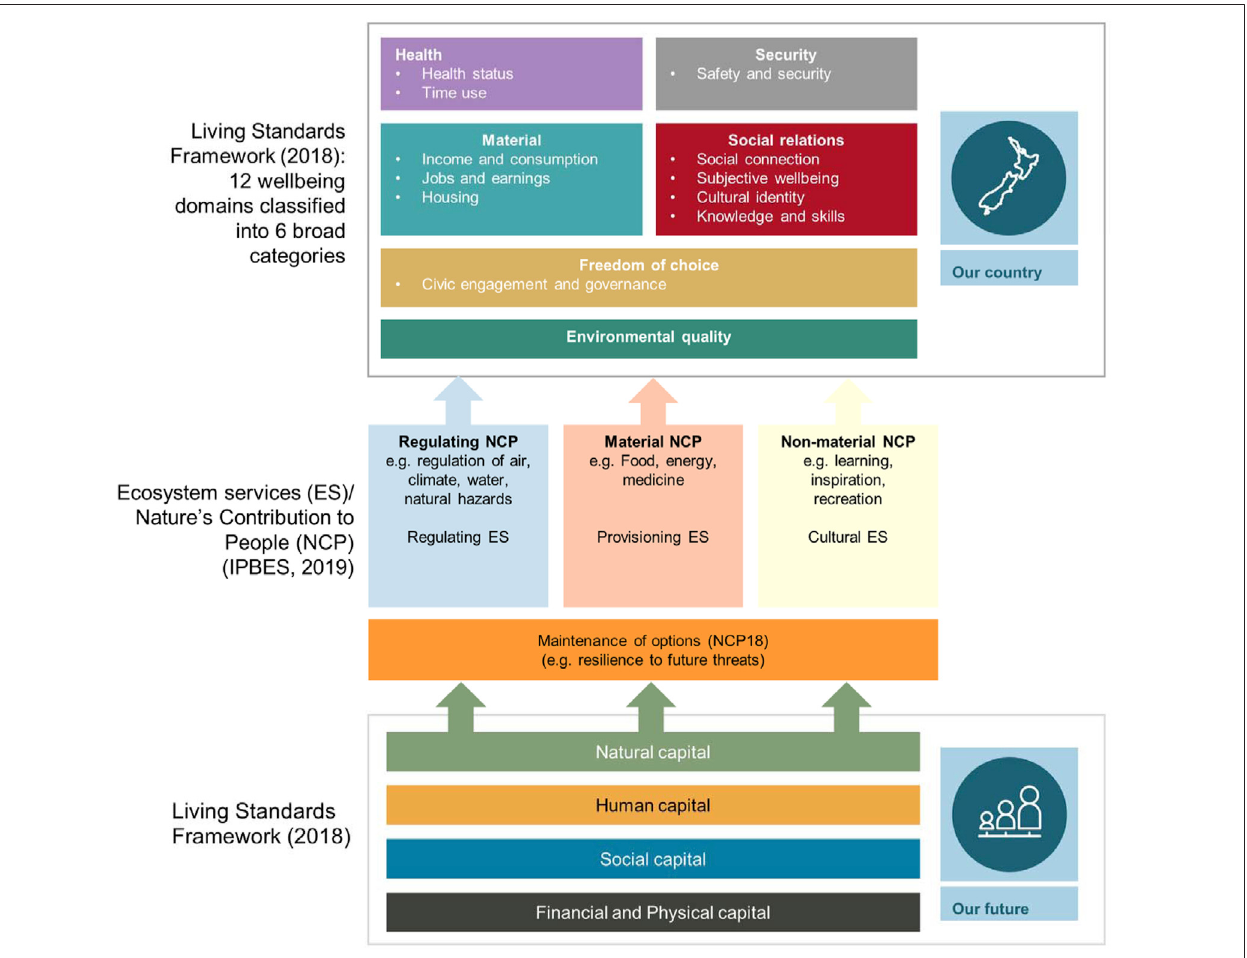
FIGURE2| Linkingnaturalcapital(from “ OurFuture ” )andcurrentwell-beingdomains( “ OurCountry ” )fromtheNewZealandLivingStandardsFramework(Source: New Zealand Treasury 2019a) with the ecosystem services (ES) and Nature ’ s Contributions to People (NCP) (IPBES, 2019). The ES/NCP are an intermediate concept connecting natural capital and well-being.